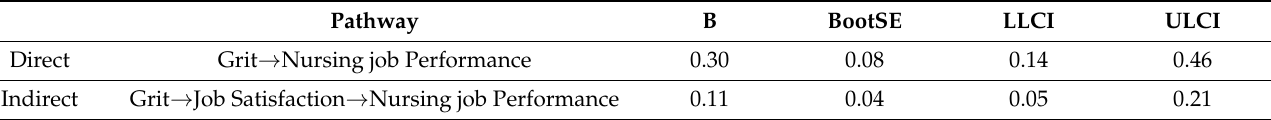
Table 4. Verifying the bootstrapping mediation